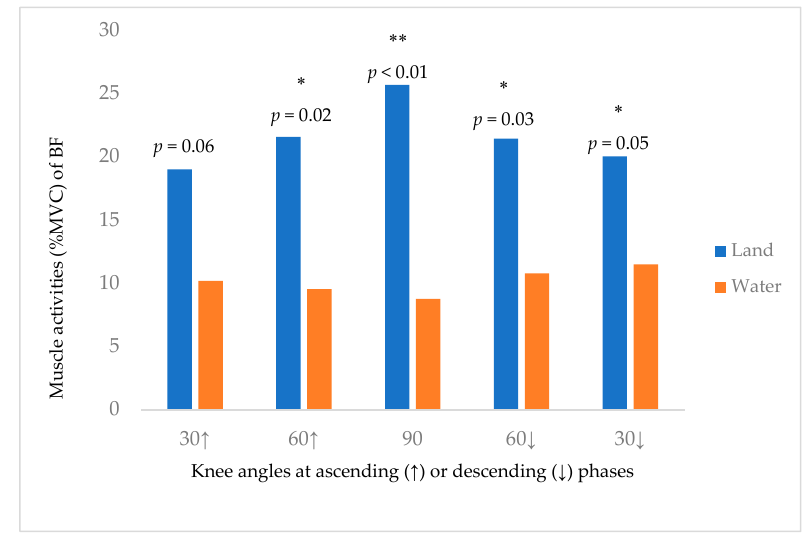
Figure 5. The Muscle Activity of BF (%MVC) at different knee angles (degree) during squatting. * significant at p < 0.05, ** significant at p < 0.01; ( ↑ ) ascending phase; ( ↓ ) descending phase .